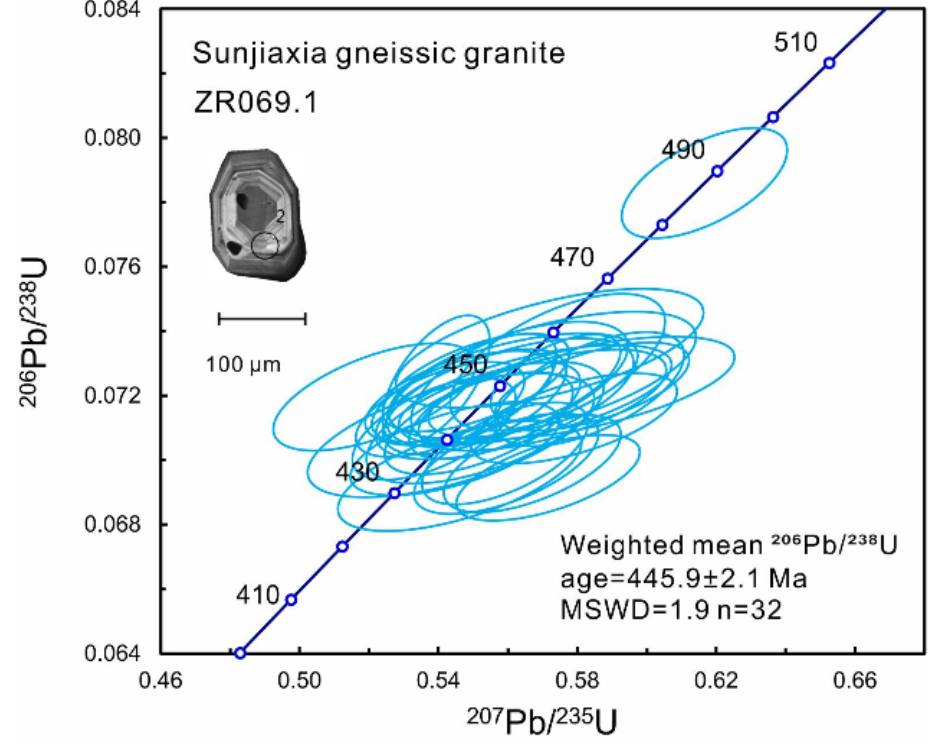
Figure 12. LA-ICP-MS U-Pb Concordia diagram of zircons from Sunjiaxia gneissic granite (ZR069.1).